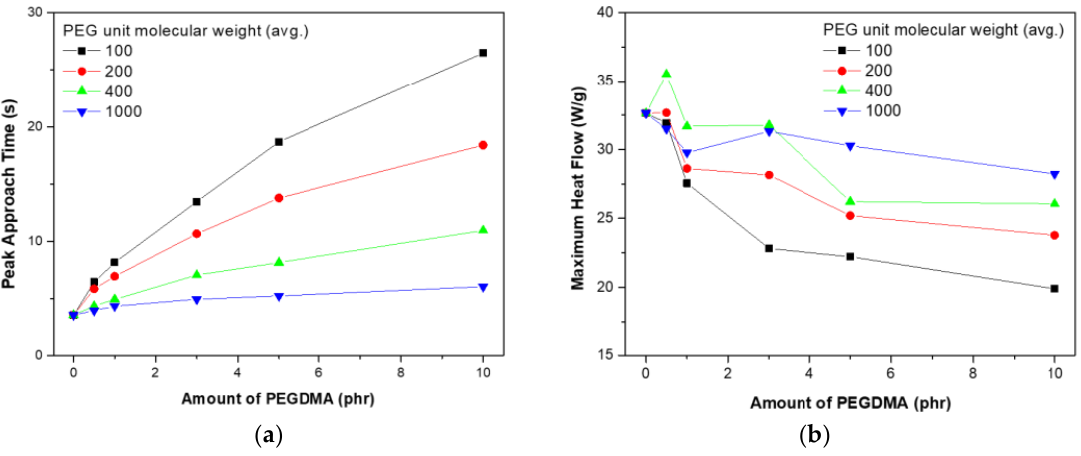
Figure 5. Change in reactivity with size of poly (ethylene glycol) dimethacrylate (PEGDMA) as determined using photo-DSC: ( a ) peak approach time; ( b ) maximum heat flow.